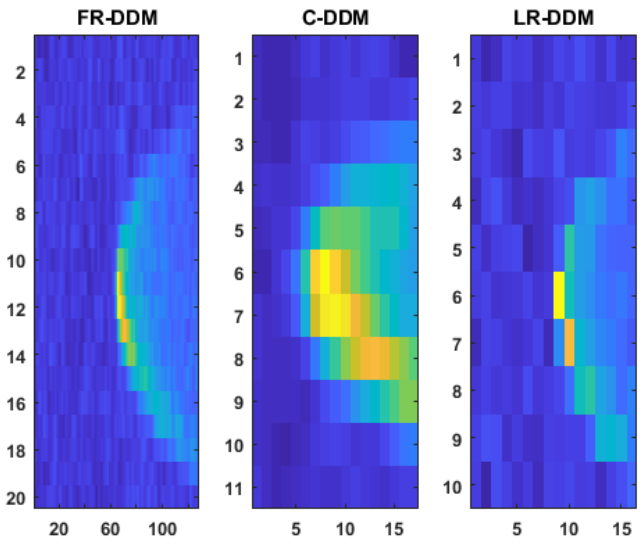
Figure 2. Example of CYGNSS DDM instrument (DDMI) onboard-processed 1 Hz FR-DDM (left), compressed DDM (middle), and author-generated LR-DDM (right). Table 2. List of collected Level 0 (L0)